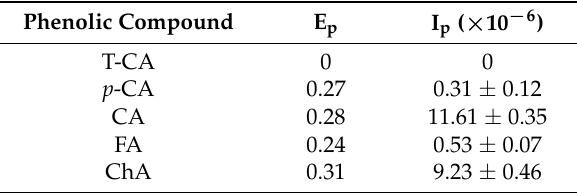
Figure 7. Cyclic voltammograms taken with a 3-mm glassy carbon electrode at 100 mVs − 1 of: 0.5 mM cinnamic acid (mazarine line), p -coumaric acid (green line), caffeic acid (red line), ferulic acid (carmine red), and chlorogenic acid (blue red) in 50 mM phosphate buffer of pH 7.0. Table 1. Evaluation of the anodic peak potentials of the studied cinnamic acid derivatives (E p —anodic peak potential (V)) at pH 7.0, as well as the anodic peak currents at pH 7.0 (I P —anodic peak current (A)) during the cyclic voltammetry